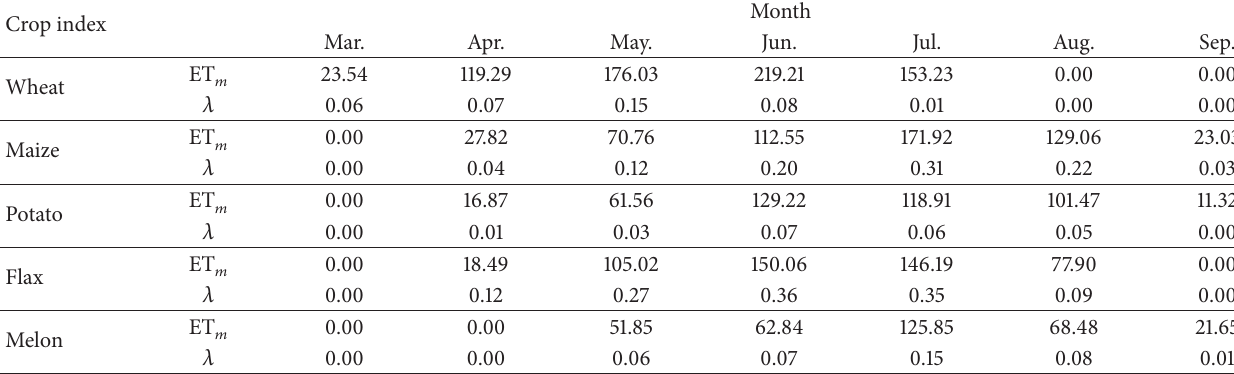
Table 3: The fitted value of ET 𝑚 (mm) and 𝜆 .